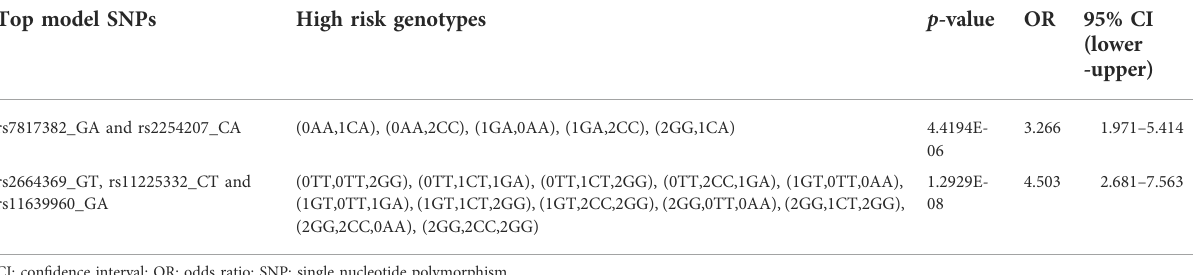
TABLE 2 Multivariable logistic regression analysis results for the signi fi cant 2-way and 3-way GMDR 0.9 models in the MMP dataset (overall survival). Top model